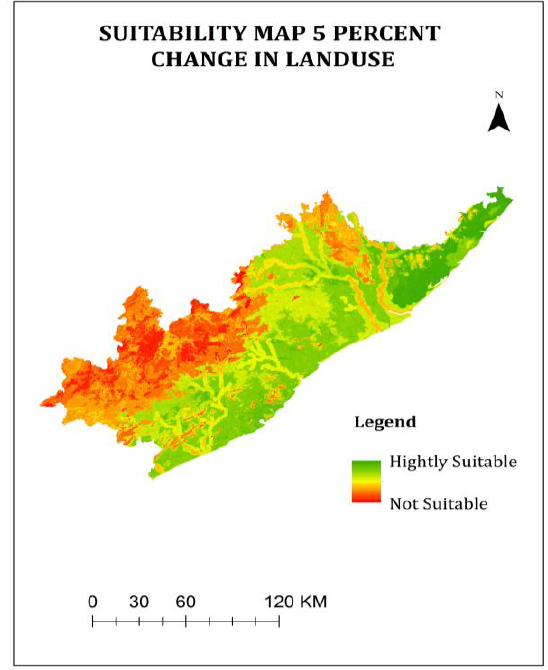
Fig 10: Suitability map with 5 percent change